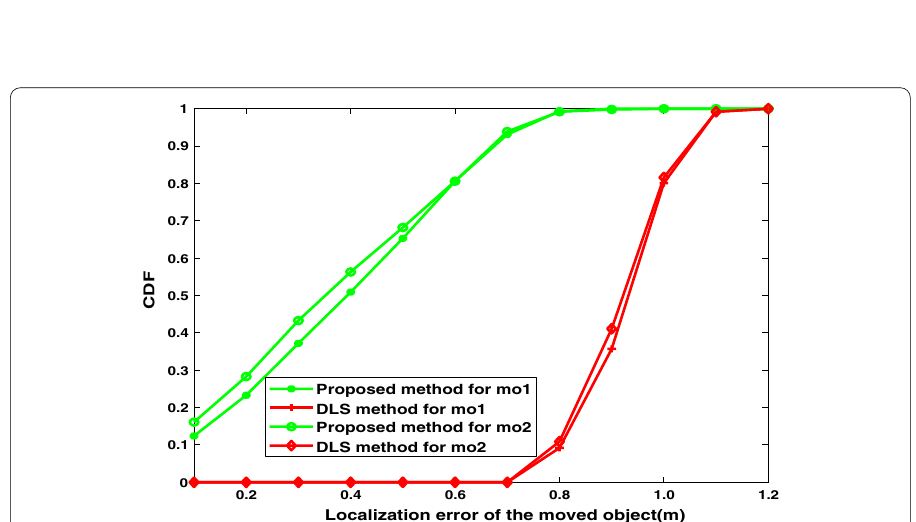
Fig. 11 Localization error CDF comparison by different visual fingerprint relocation method when there are two displaced